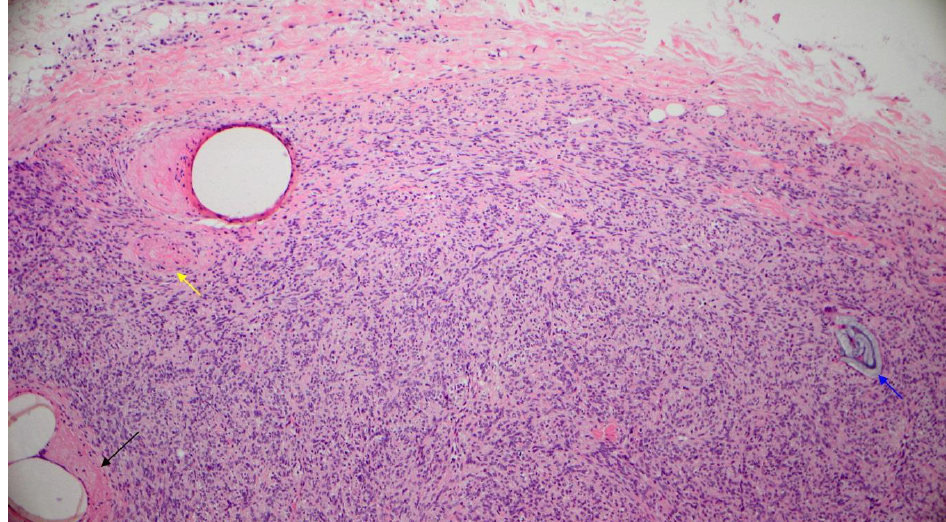
Figure 6. Encapsulated tumor with thrombosed vessels (black and yellow arrows). There is also presence of embolizing material used (blue arrow) (hematoxylin and eosin stain, 10×).